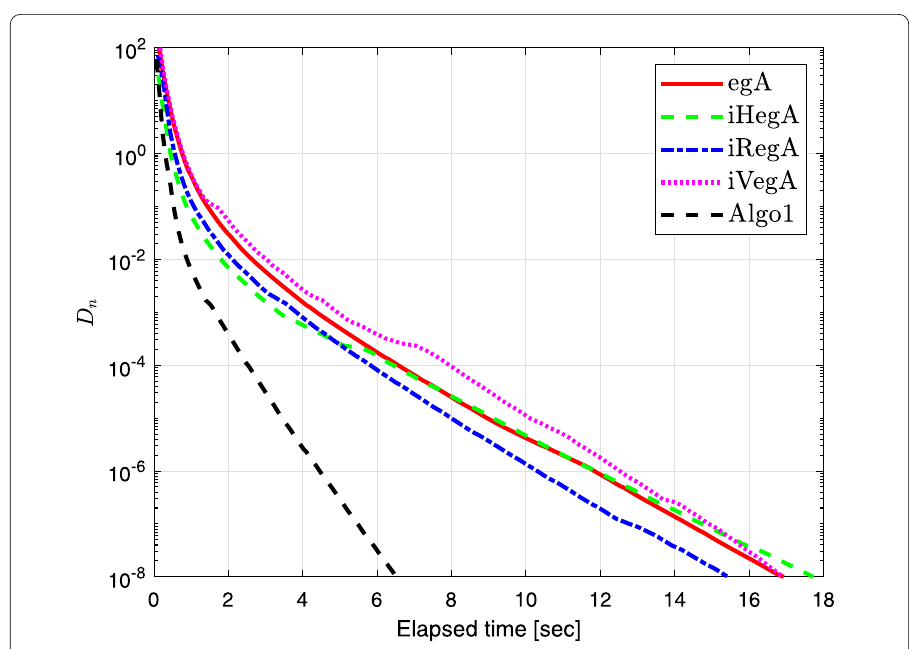
Figure 5 Example 5.1 when n = 600: the number of iterations is 173, 171, 153, 146, 133,